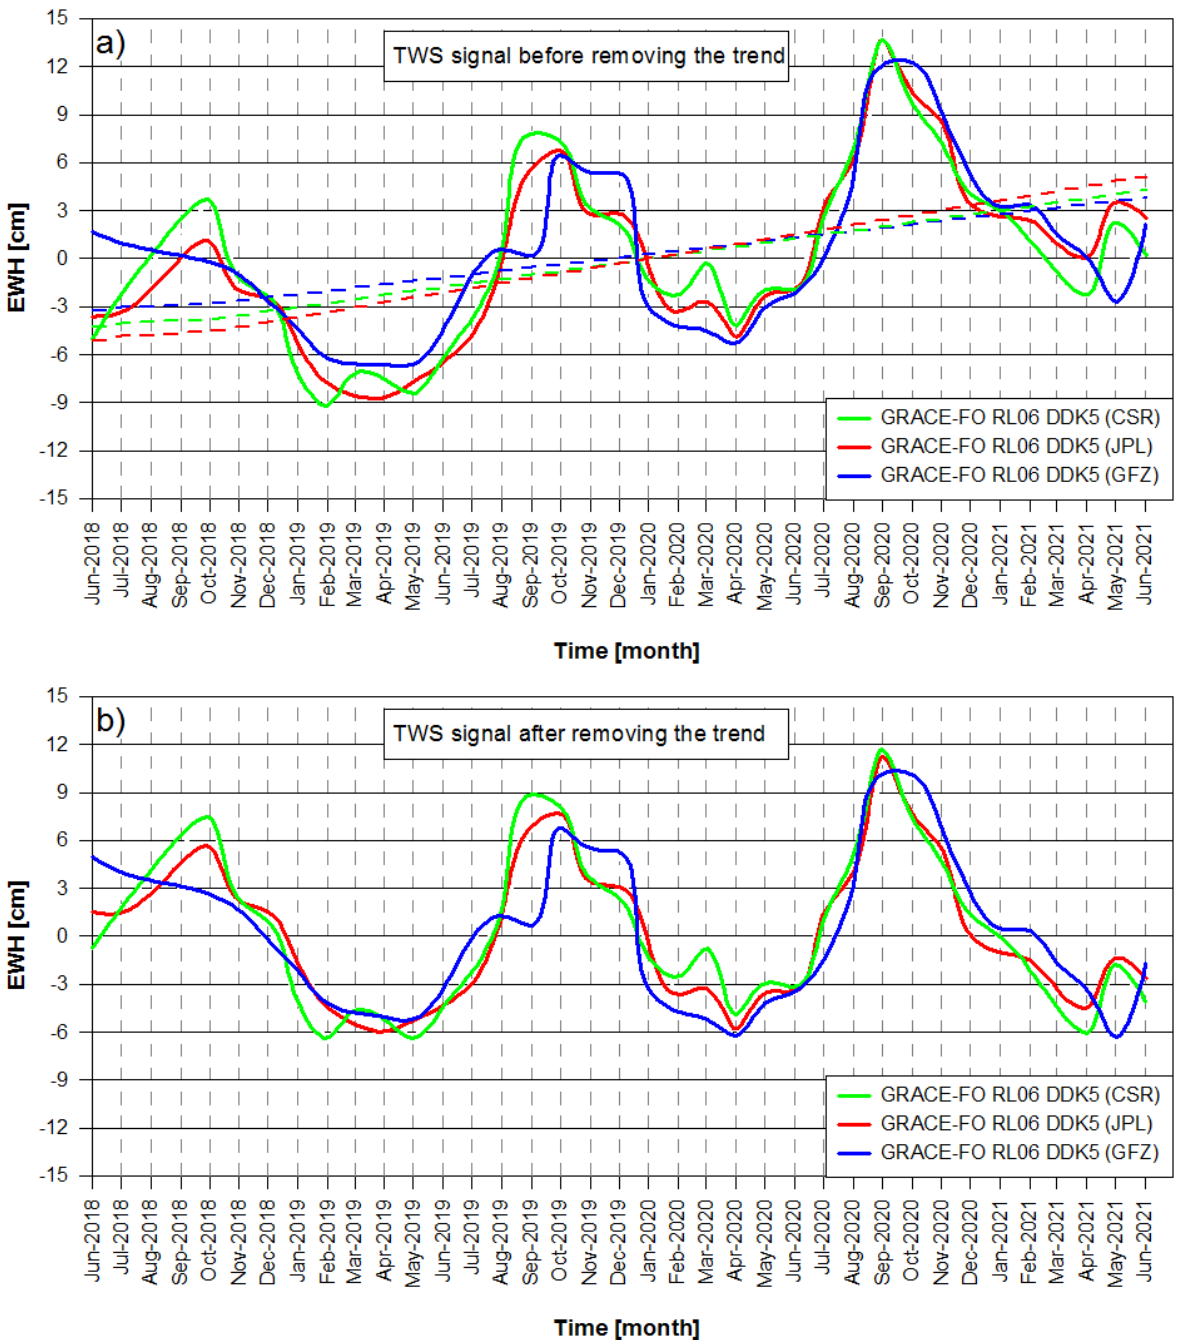
Figure 3. Mean basin average of the TWS signal in terms of EWH [in cm] over the NRB; ( a ) before and ( b ) after removing the trend (dashed lined) as derived from the DDK5 of GRACE-FO (RL06) products from the three official centers GFZ, CSR, and JPL.